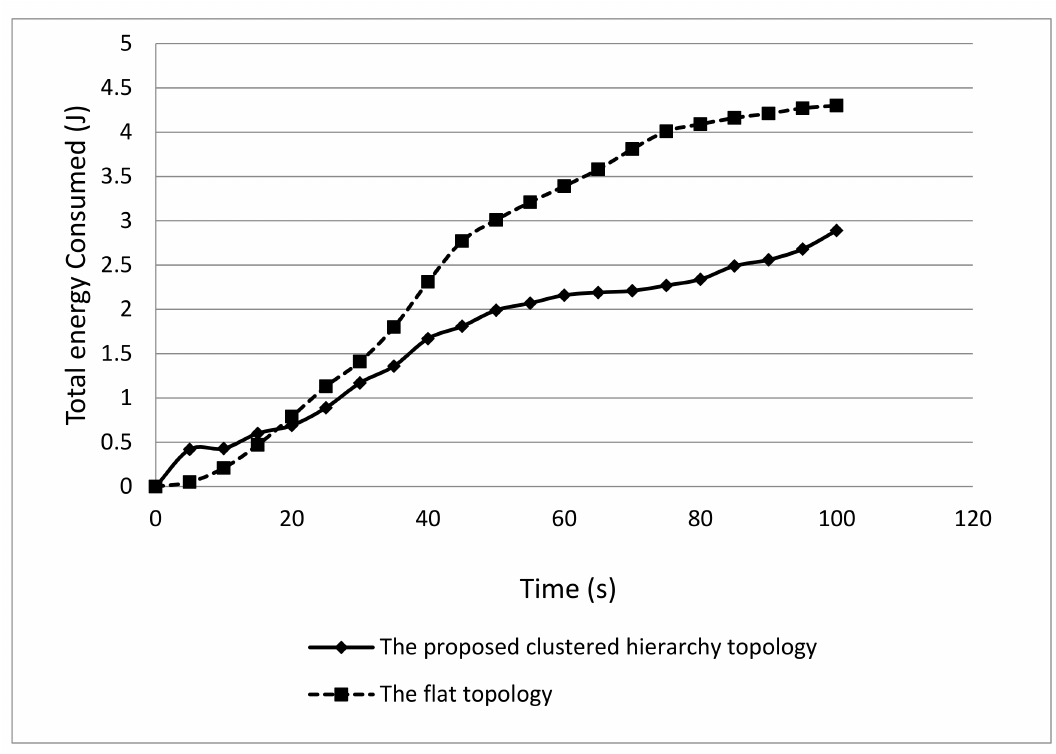
Figure 7. Total energy